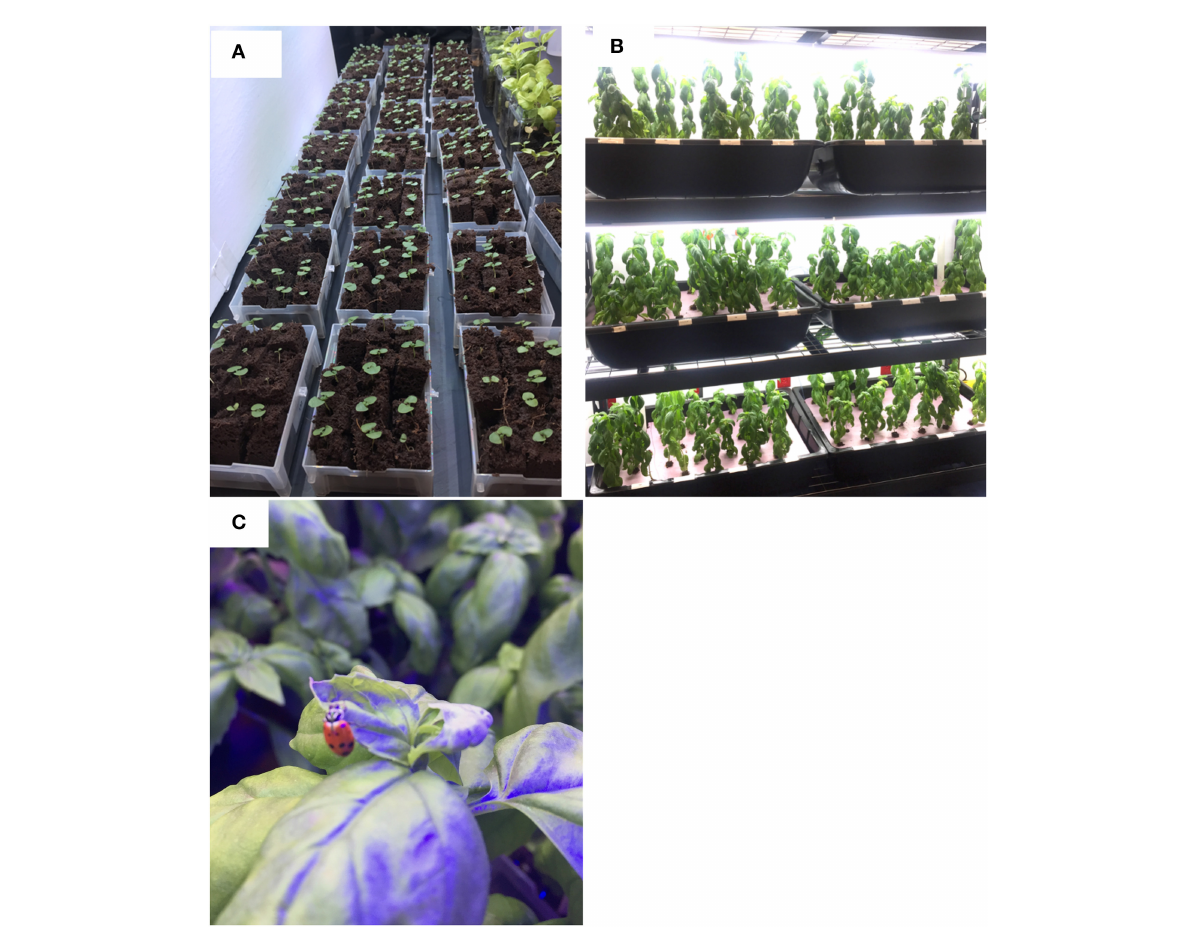
FIGURE1 (A) Basil seedlings after 5 days of germination, in sterile growth sponges; (B) Adult basil plants, in the hydroponics system at the University of Toronto; (C) Lady bug ( Coccinellidae ) on basil leaves, applied on the plants for biological control of